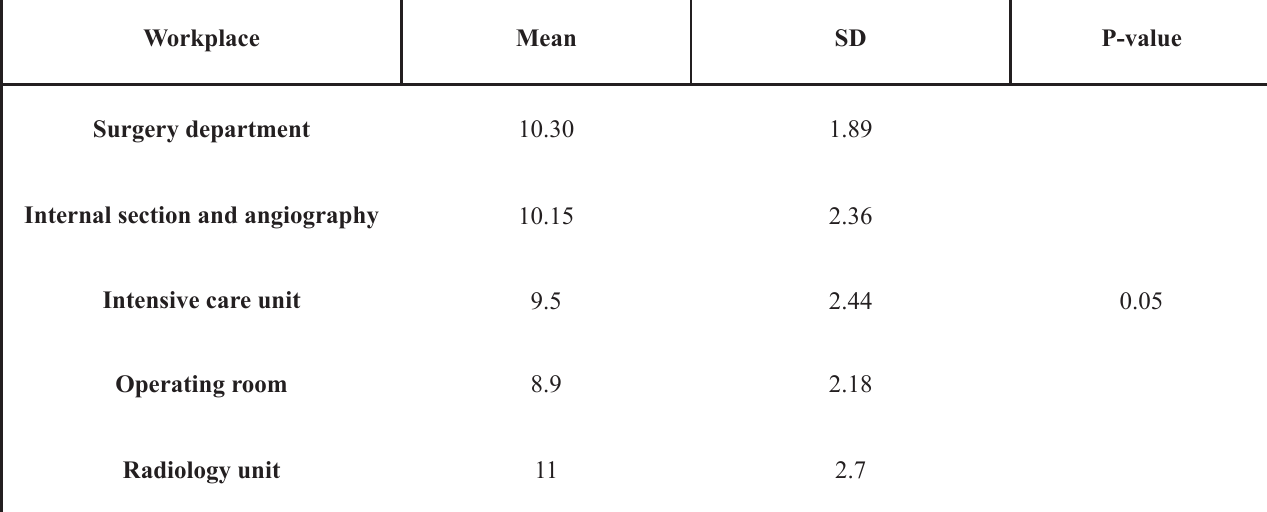
Table 4. Scores of knowledge of medical staff about the principles of radiation protection in terms of workplace